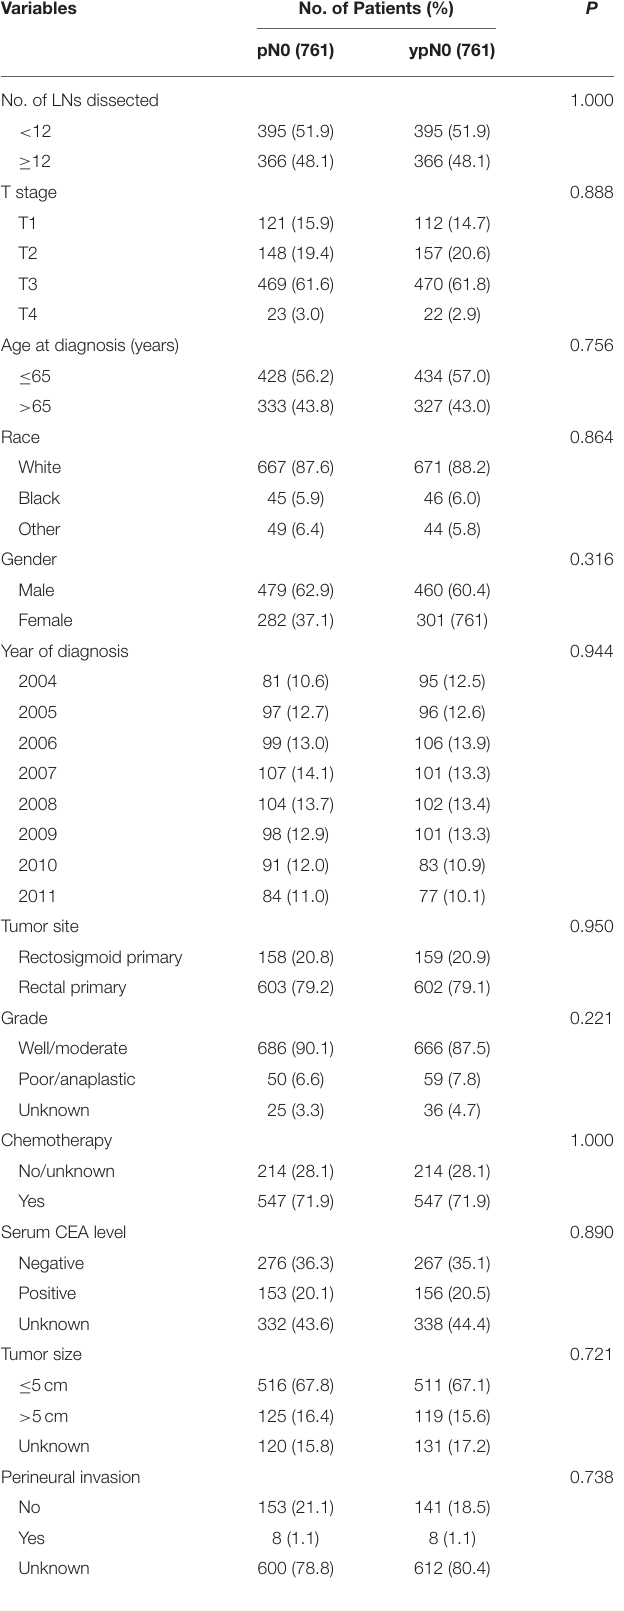
TABLE 3 | Patients’ baseline characteristics after